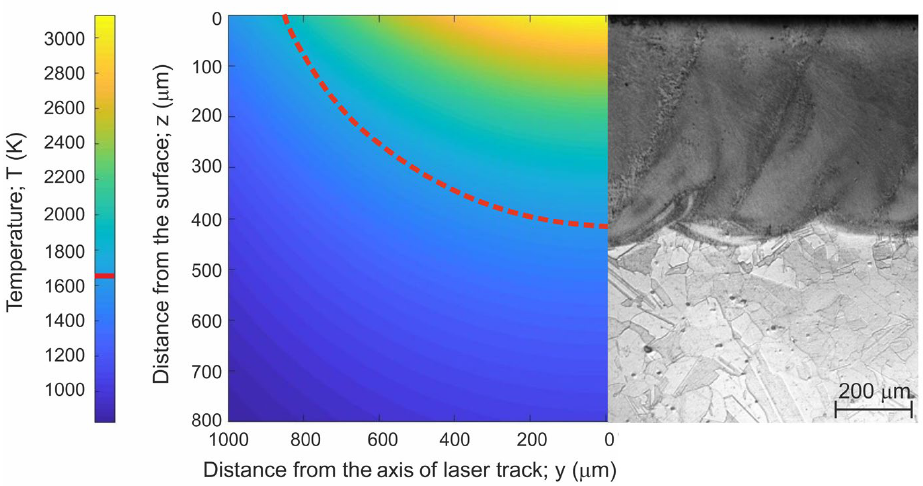
Figure 10. A 2D cross-section of the temperature distribution in the molten pool with marked melting point of Nimonic 80A alloy and the OM microstructure of laser borided layer produced at the laser beam power of 1.56 kW.